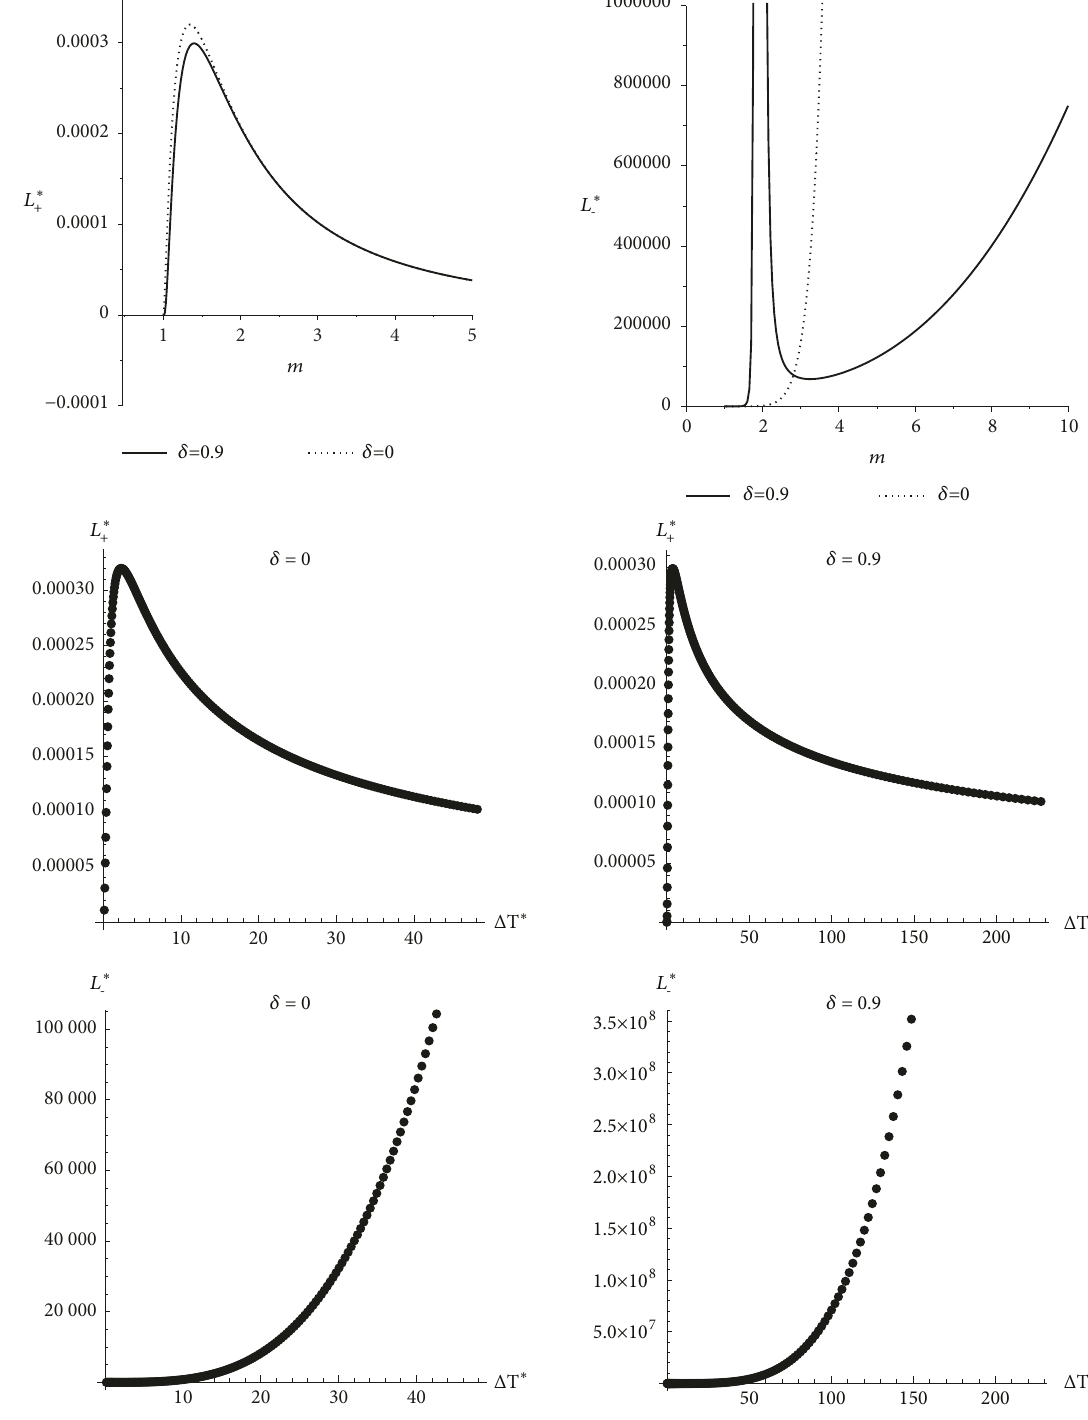
Figure 7: Diagram of exterior and interior horizons luminosity 𝐿 ∗ ± is plotted against 𝑚 and Δ𝑇 ∗ for 𝛿 = 0 and 0.9.